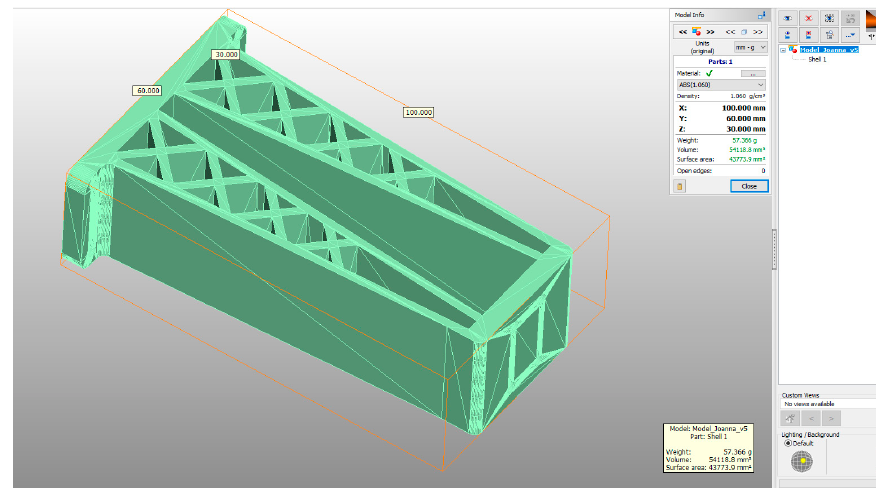
Figure 5. The 3D model (CAD) of a car mirror holder in the 3D-Tool program. The subsequent stage was the selection of methods and materials for printing. The materials used for printing were the RGD720 photopolymer resin (applied method: PolyJet), ABS M30 thermoplastic (applied method: FDM), E-Partial photopolymer resin (applied method: DLP), PLA thermoplastic (applied method: FFF), and ABS thermoplastic (applied method: MEM). The materials used for printing, together with the model weight, thickness, and area, are presented in Table 1. Table 1. Materials applied in the printing of particular models, presented as designed in the 3D-TOOL program. RM1 RM2 RM3 RM4 RM5